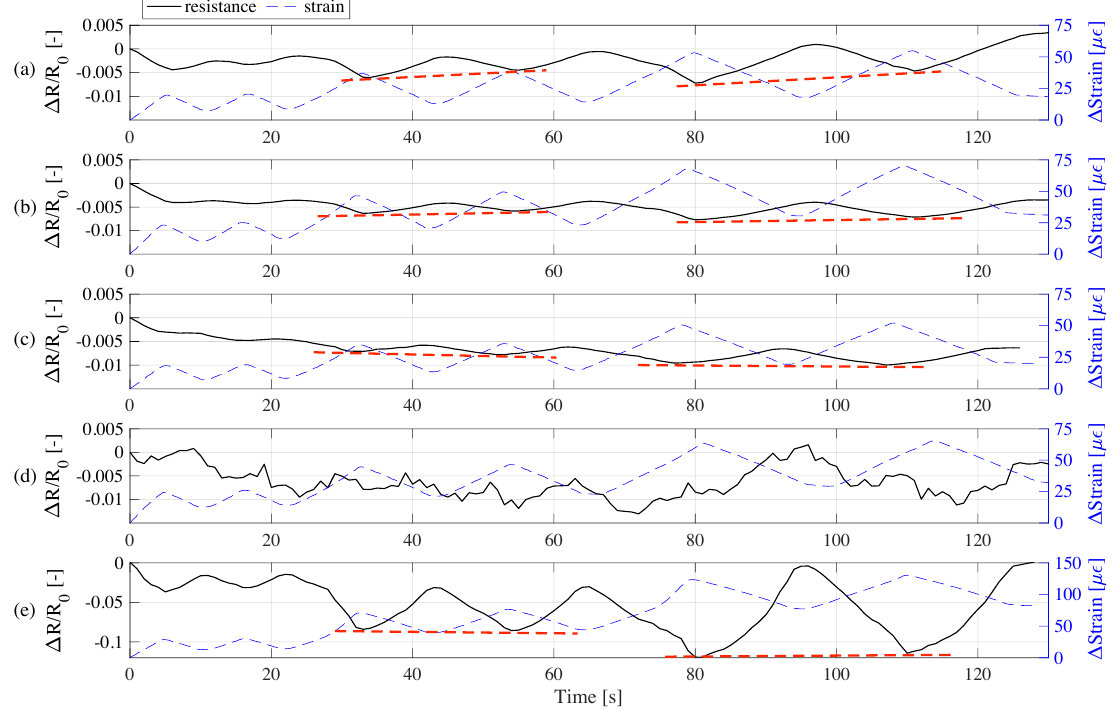
Figure 7. Typical time series of relative change in resistance and strain loading under each sample: ( a ) 0%; ( b ) 10%; ( c ) 20%; ( d ) 30%; and ( e ) 40% graphite-to-cement